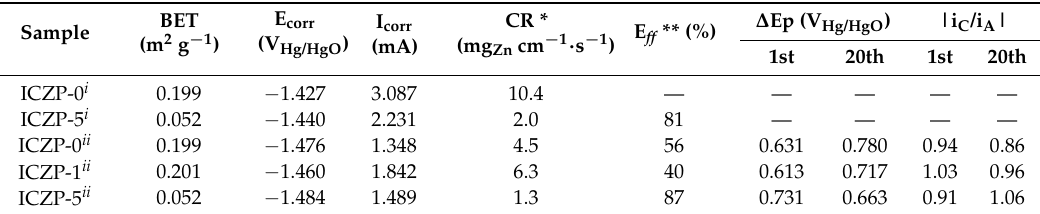
Table 2. Zinc electrode reversibility and protective additive efficiency for the modified aqueous alkaline electrolyte and Nafion ® ionomer as the